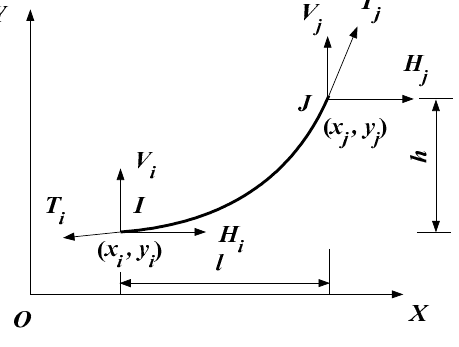
Figure 1. An elastic catenary cable segment.